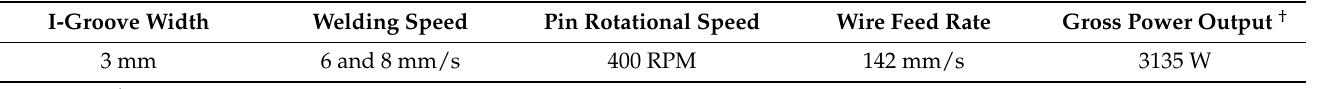
Table 2. Summary of operational conditions used in the two HYB butt welding